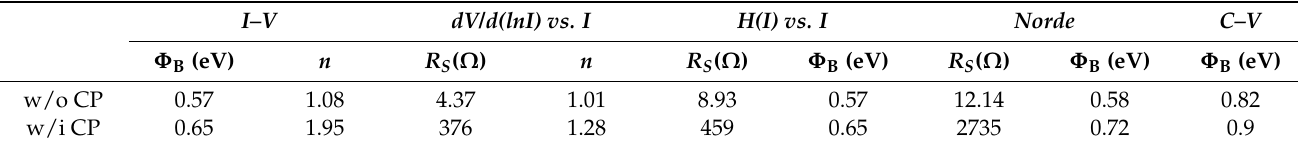
Table 1. Schottky diode parameters derived using various methods. CP, carbon paste. I–V